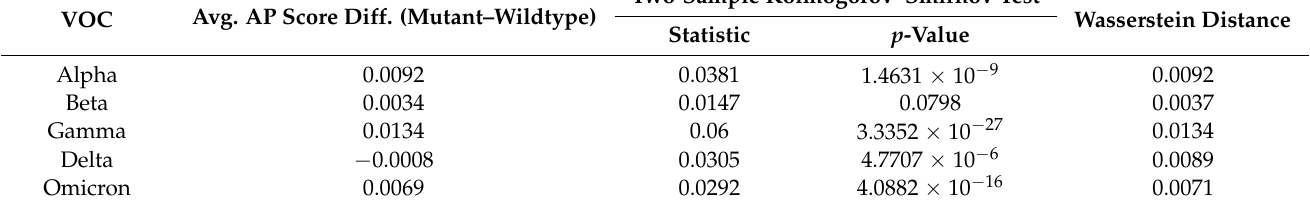
Table 1. Different metrics summarizing the difference in AP scores between mutant and wildtype peptides within a VOC. Three different methods were used to compare the distributions: (i) the average difference in AP scores, (ii) the two-sample Kolmogorov–Smirnov (KS) test, (iii) and the Wasserstein distance.